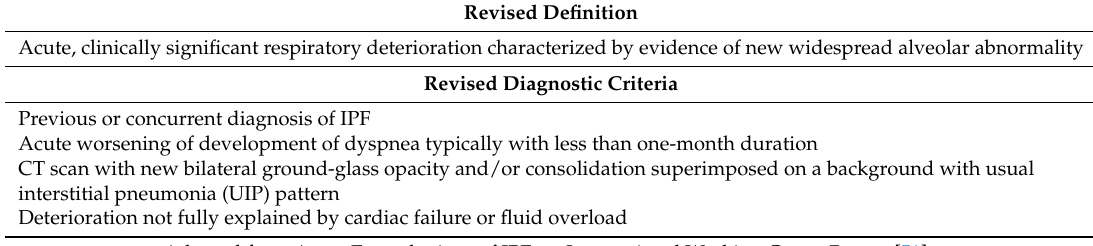
Table 3. Definition and diagnostic criteria for acute exacerbation of